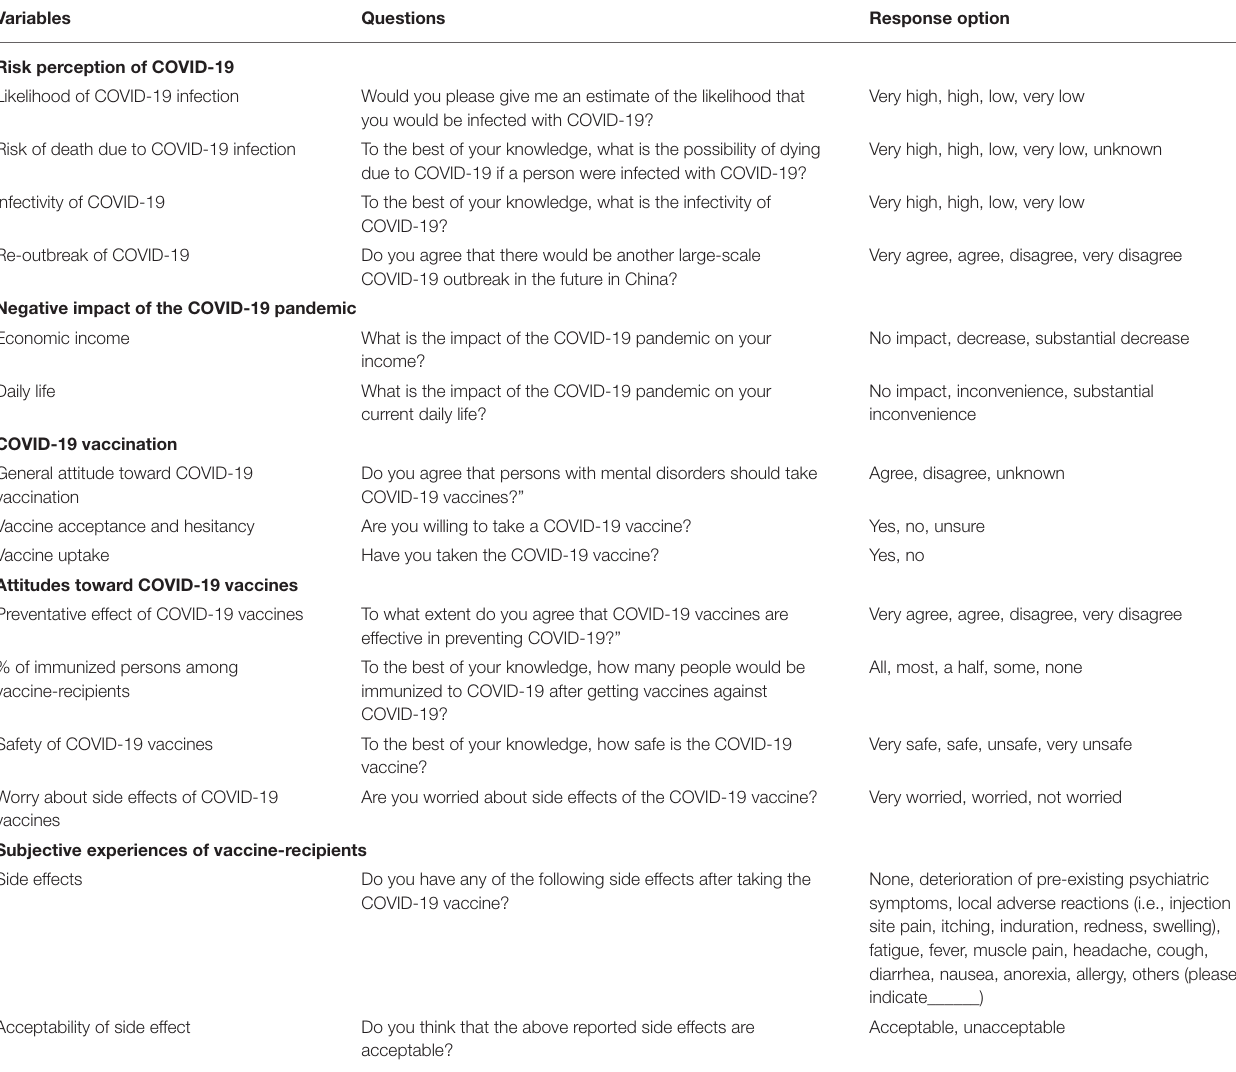
TABLE 1 | Questions used for assessing risk perception of COVID-19, negative impact of the COVID-19 pandemic, COVID-19 vaccination, and attitudes toward COVID-19 vaccines in the survey